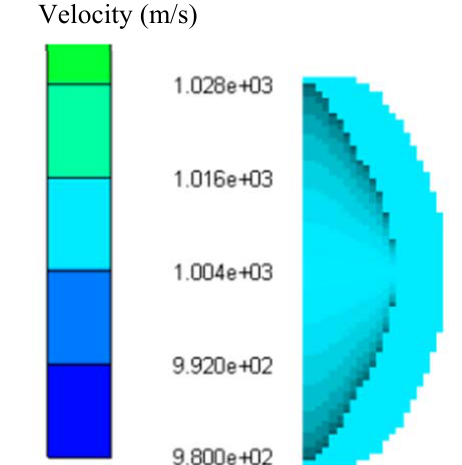
Figure 20. Velocity and shape of copper made penetrator (Autodyn); after 100 µs (liner thickness = 4 mm) [8] For a variable liner thickness of 2 mm in the center, and 1 mm on the periphery, the liner mass is around 9.5 g and the penetrator velocity is around 1618 m/s (Figure 21). The kinetic energy of this penetrator is around 12.45 kJ, after 100 µs. [8]